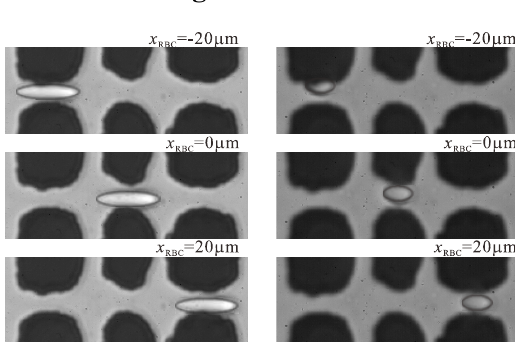
( b ) Photographs of the RBCs (left: normal RBC, right: rigidified